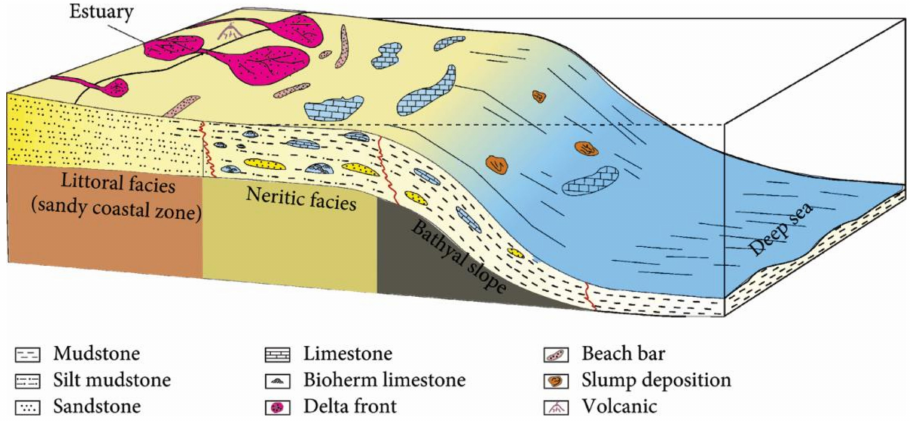
Figure 14. Depositional model of the Kuldana Formation in the area of Yadgaar section, Muzaffarabad.